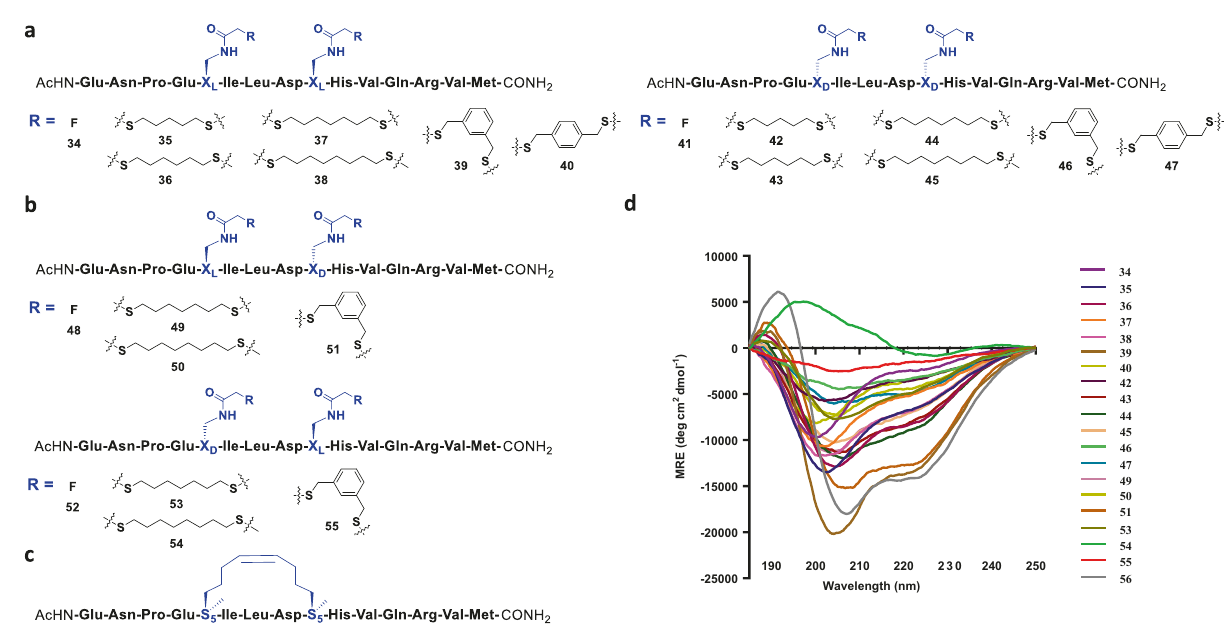
Fig. 3 FTDR-based coupling between an unprotected Axin peptide analogue and various dithiol linkers with i , i + 4 linkage. a Coupling with the unprotected analogue 34 that has both L- fl uoroacetamide substrates and the analogue 41 that has both D - fl uoroacetamide substrates, respectively. b Coupling with the unprotected analogue 48 that has L - fl uoroacetamide and D - fl uoroacetamide (N → C direction), and analogue 52 that has D - fl uoroacetamide and L - fl uoroacetamide (N → C direction), respectively. c The reported Axin peptide analogue 56 was prepared based on ring-closing metathesis. d Circular dichroism (CD) spectra of all peptide analogues. Coupling amino acids X L /X D /S 5 were highlighted in